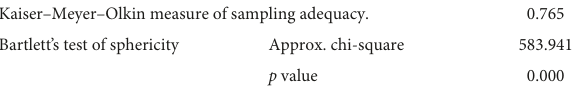
TABLE 3 Results of the test statistics for EFA analysis in the attitude section of the validation study. Kaiser–Meyer–Olkin measure of sampling adequacy.